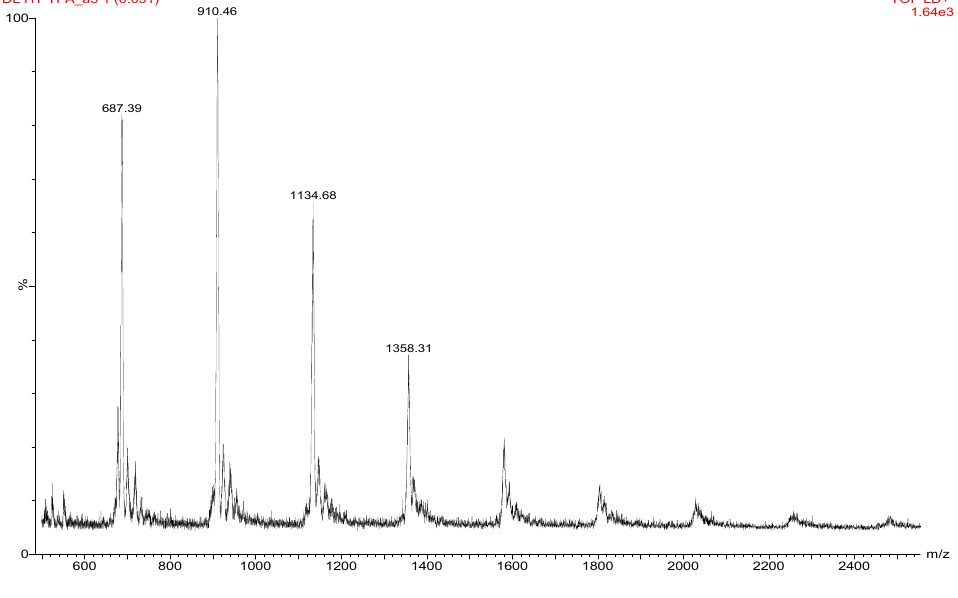
Figure 1. MALDI spectrum of the synthesized